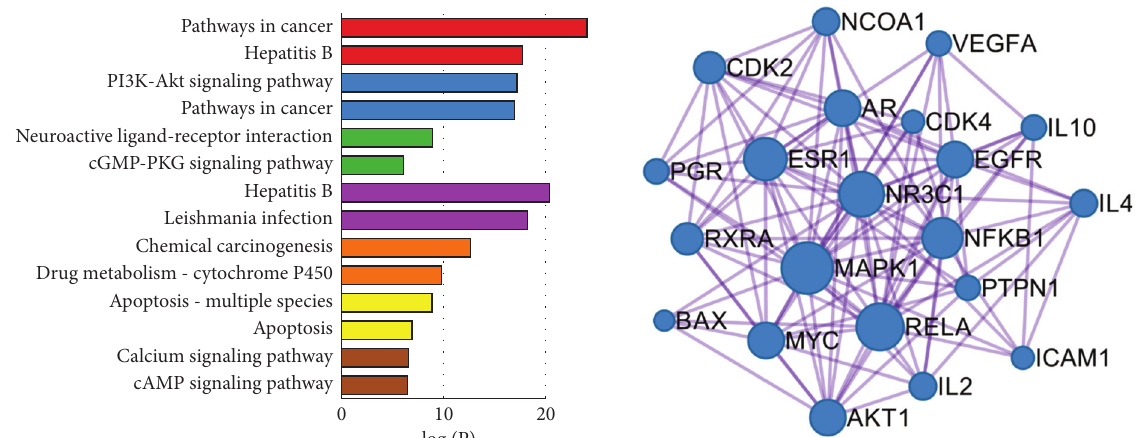
Figure 5: Pathway enrichment analysis of